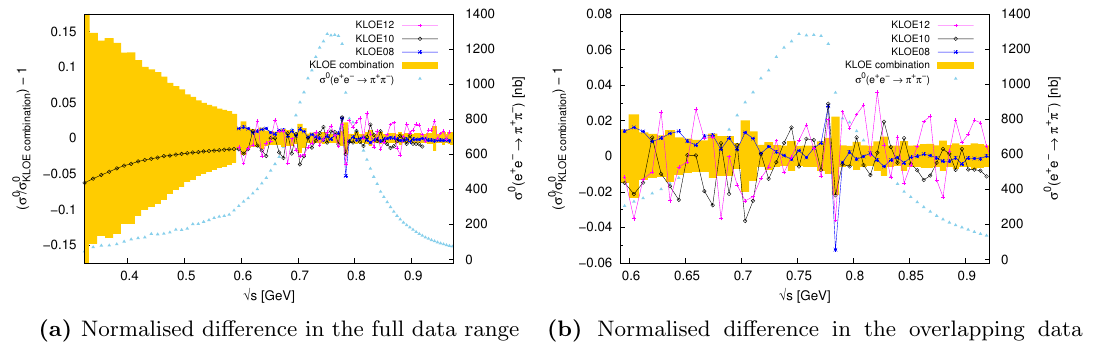
Figure 5. The normalised di(cid:11)erence of the KLOE combination and the individual KLOE mea- surements, where the yellow band represents the statistical and systematic uncertainties of the KLOE combination summed in quadrature and the KLOE08, KLOE10 and KLOE12 cross section measurements are given by the blue, black and pink markers, respectively (colour online). Here, the errors bars of the individual measurements are not shown in order to be able to distinguish the data points, but are in good agreement with the KLOE